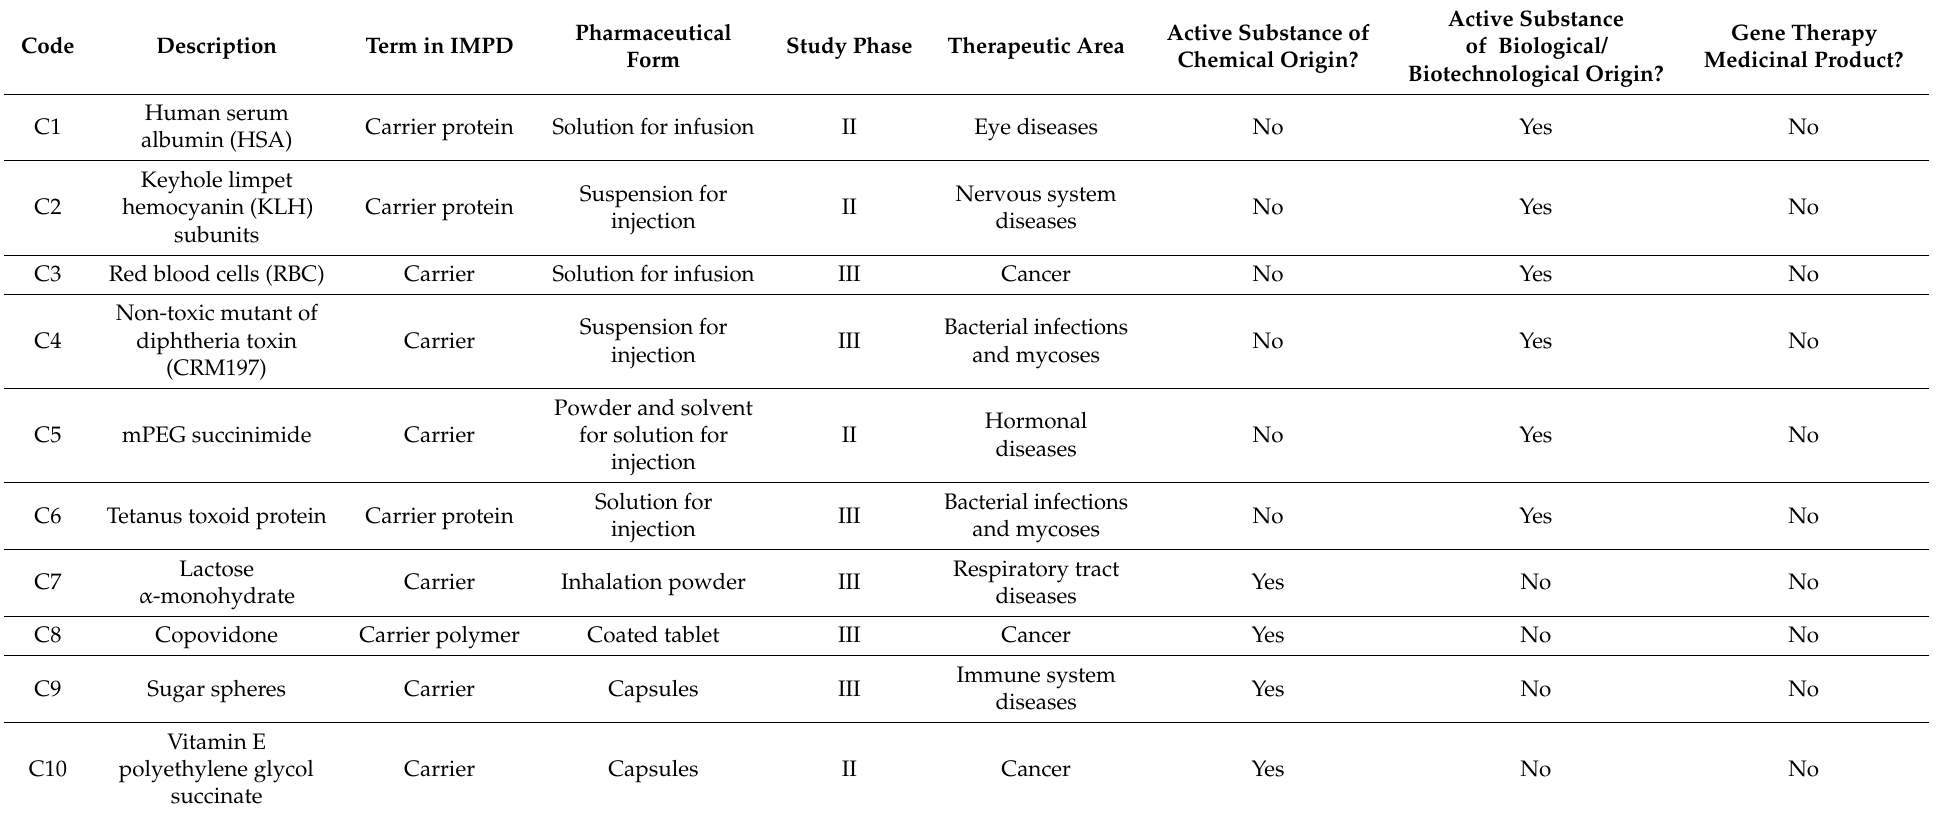
Table 2. Carriers described in the